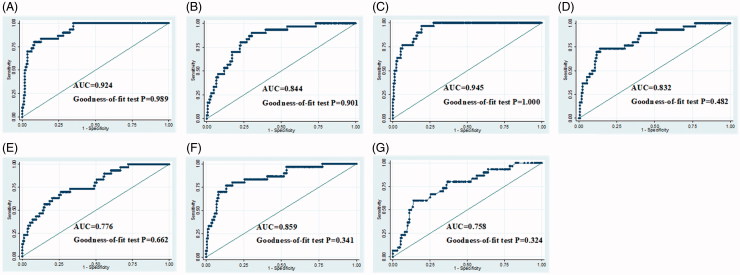
A-G: Shown are clinical models from models A–G.